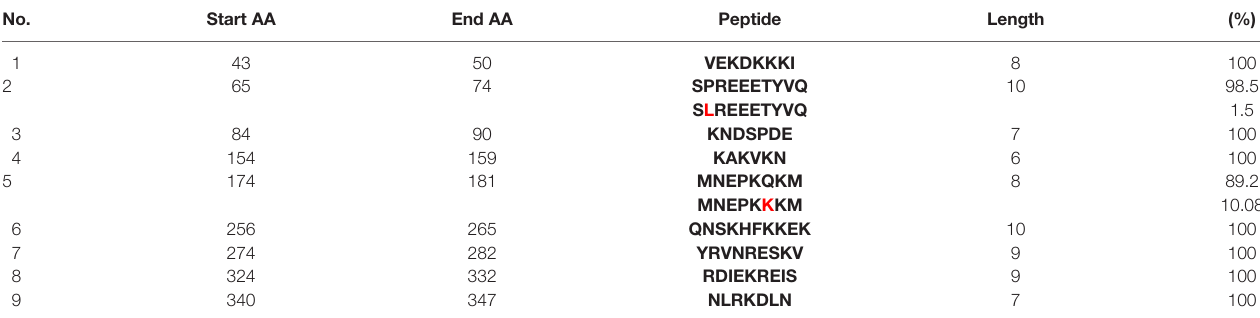
TABLE 4 | Diversity of the common epitopes predicted by both servers and their prevalence in 65 clinical isolates of P. vivax RhopH2 . No. Start AA